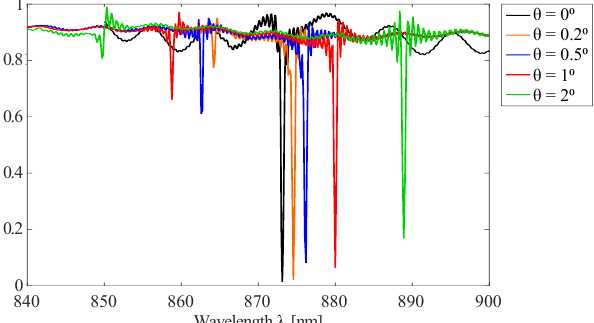
Figure 10. Simulated transmission spectra for oblique incident angles θ for the GMR grating in EpoCore. The used grating parameters are listed in Table